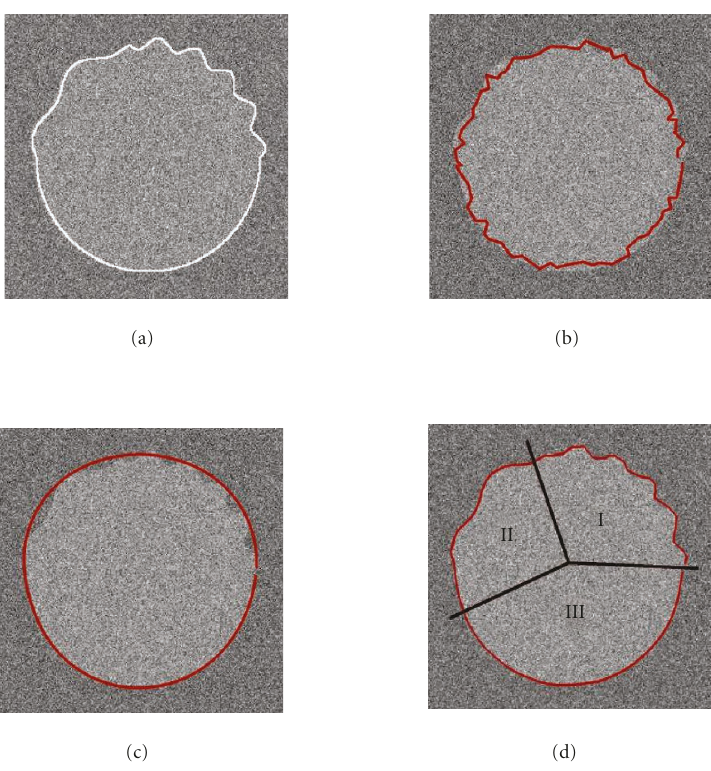
Figure 13: Constant and locally regularized 100-points smoothing B-snake on a synthesis image. (a) Noisy object with the reference contour in white. (b) Final segmentation with global low λ ( λ = 1). (c) Final segmentation with global high λ ( λ = 100). (d) Locally regularized smoothing B-Snake. (I : λ = 1, II : λ = 10, III : λ = 100).